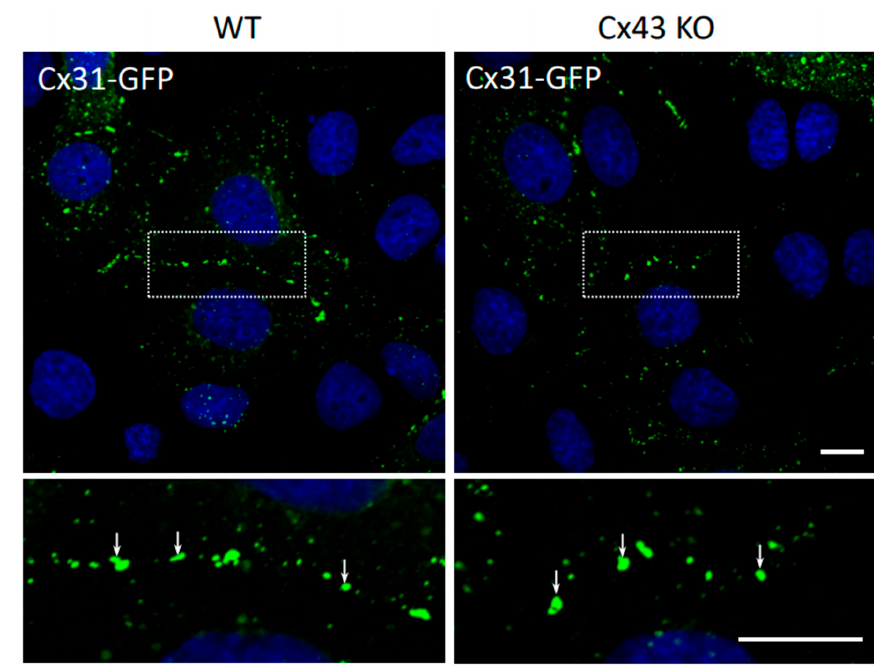
Figure 6. Cx31 assembles into gap junctions independently of Cx43. Wild-type (WT) REKs and REKs lacking Cx43 (Cx43 KO) were engineered to express Cx31-GFP. Note that both cell lines were efficient at assembling Cx31 gap junctions (arrows) as revealed by low and high magnification images. Nuclei were stained with Hoechst dye. Bar = 10 μ m.